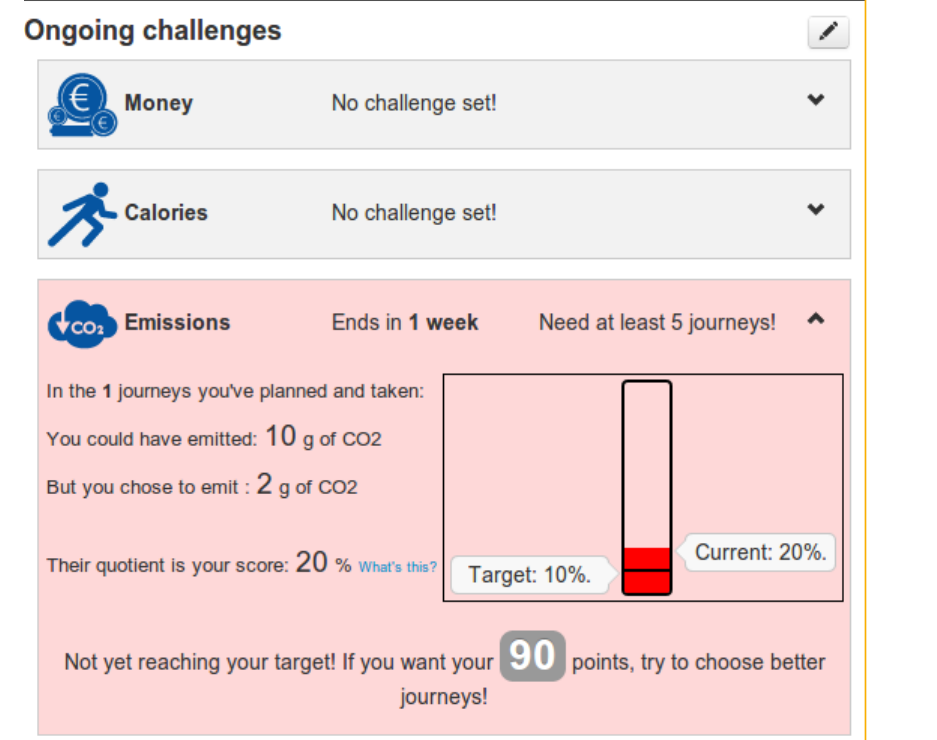
Figure 3. Illustrating the requirement to complete a minimum number of journey in order to not ‘game’ the